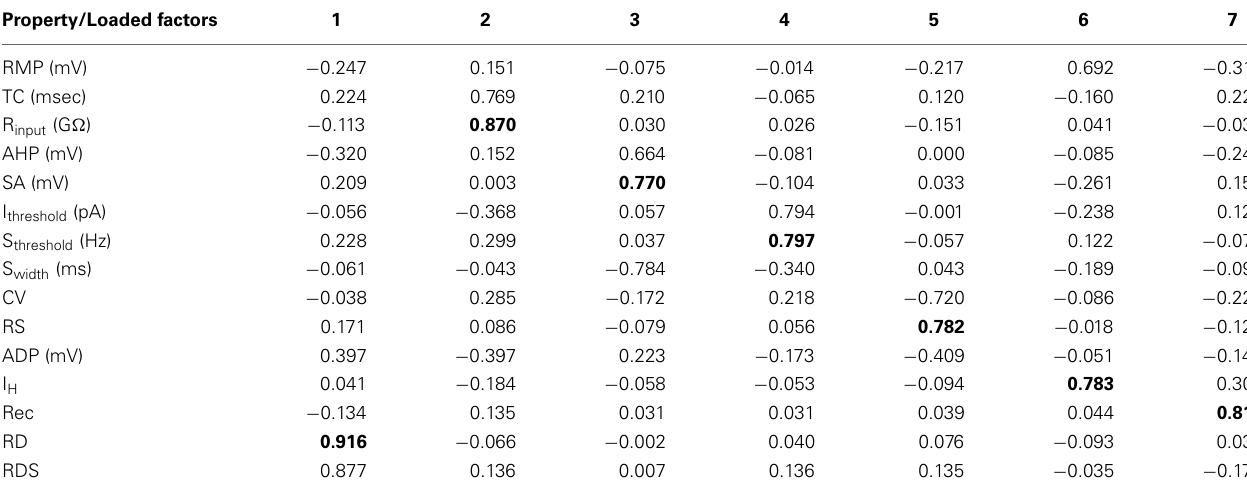
Table 1 | The rotated component matrix of variables used in our principle component analysis. Property/Loaded factors